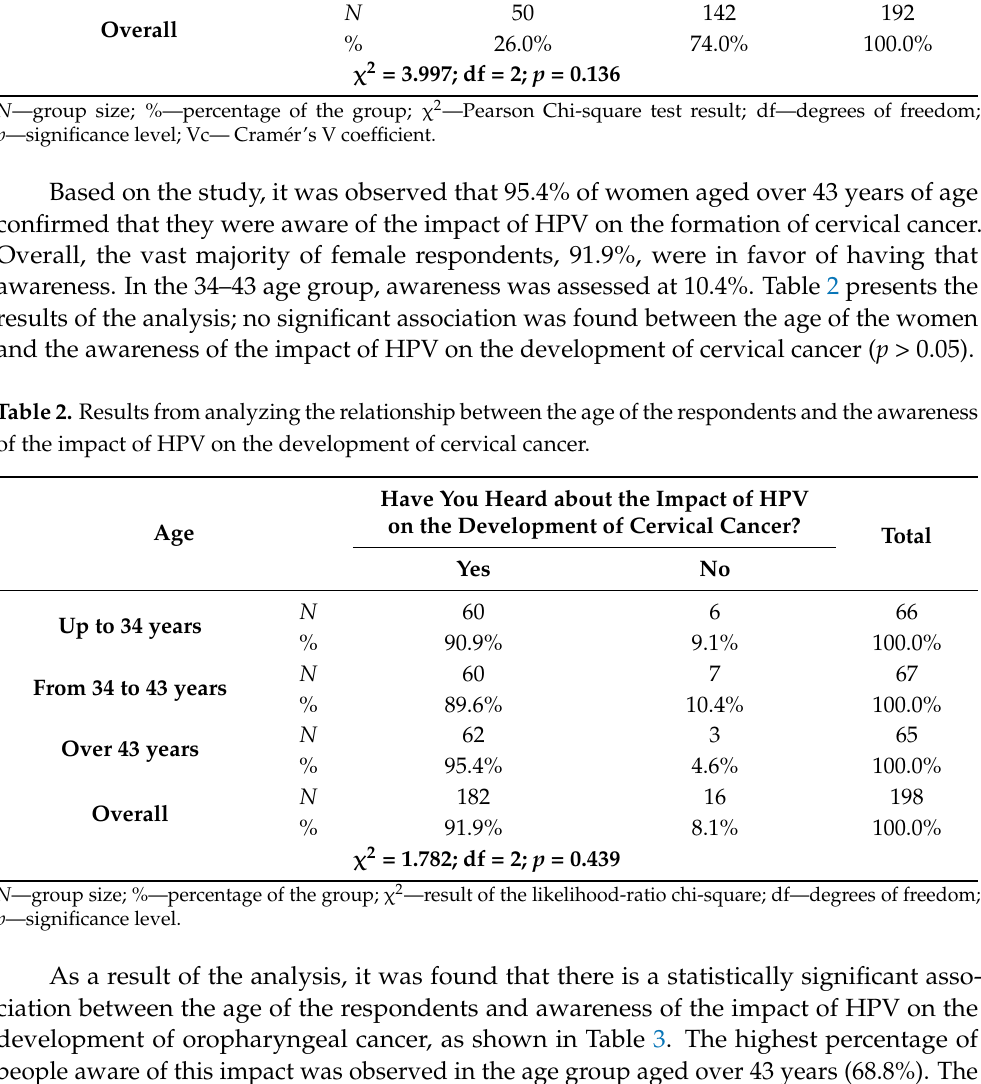
Table 1. Results from analyzing the relationship between the age of the respondents and the first examination of the cervix. Is This Your First Cervical Exam? Age Yes No N 22 43 65 Up to 34 years % 33.8% 66.2% 100.0% N 12 53 65 From 34 to 43 years % 18.5% 81.5% 100.0% N 16 46 62 Over 43 years % 25.8% 74.2% 100.0% N 50 142 192 Overall 26.0%